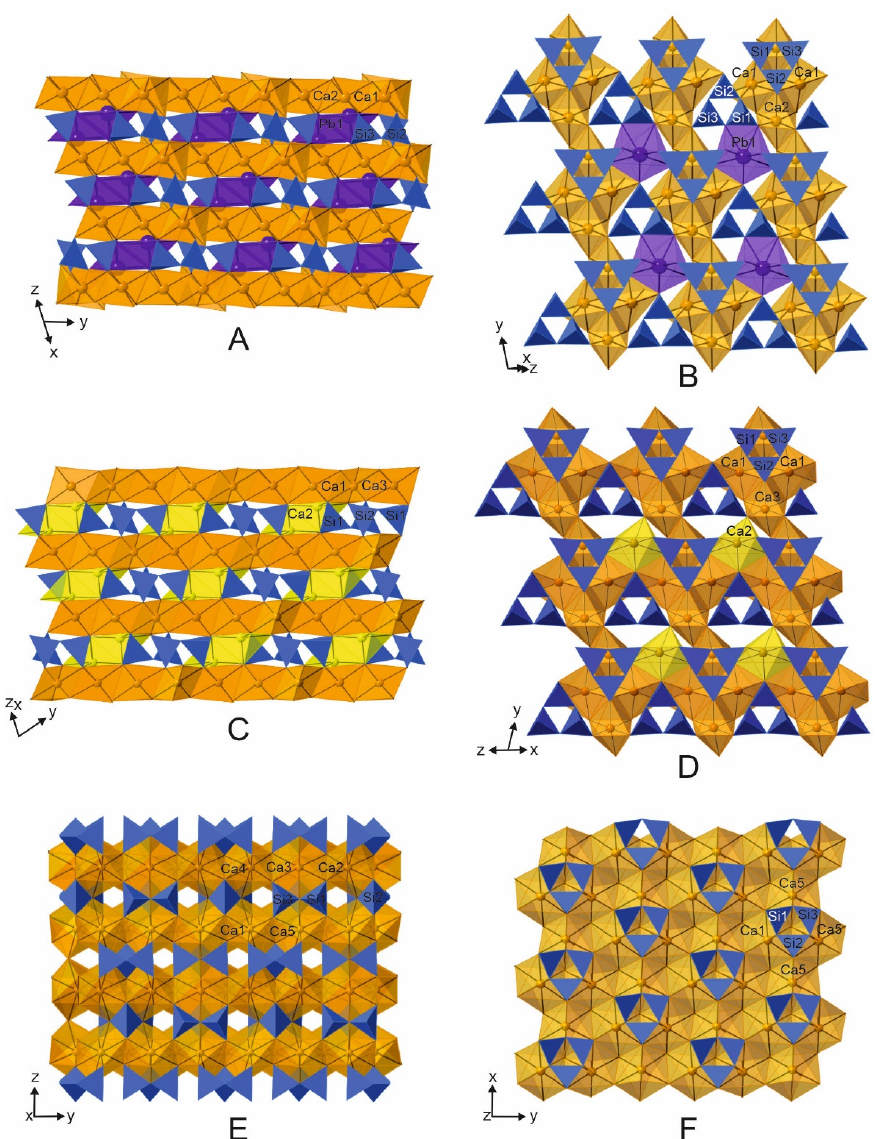
Figure 6. Crystal structures of margorosnite, PbCa 2 (SiO 3 ) 3 ( A , B ) [50], breyite, Ca 3 (SiO 3 ) 3 ( C , D ) [14] and pseudowollastonite- 2M , Ca 3 (SiO 3 ) 3 ( E , F ) [32]. Ca polyhedra: yellow-brown, Si-tetrahedra: blue, Pb-polyhedra: violet, Ca2 polyhedra (breyite): yellow. Oxygens at the tops of polyhedral are not shown.